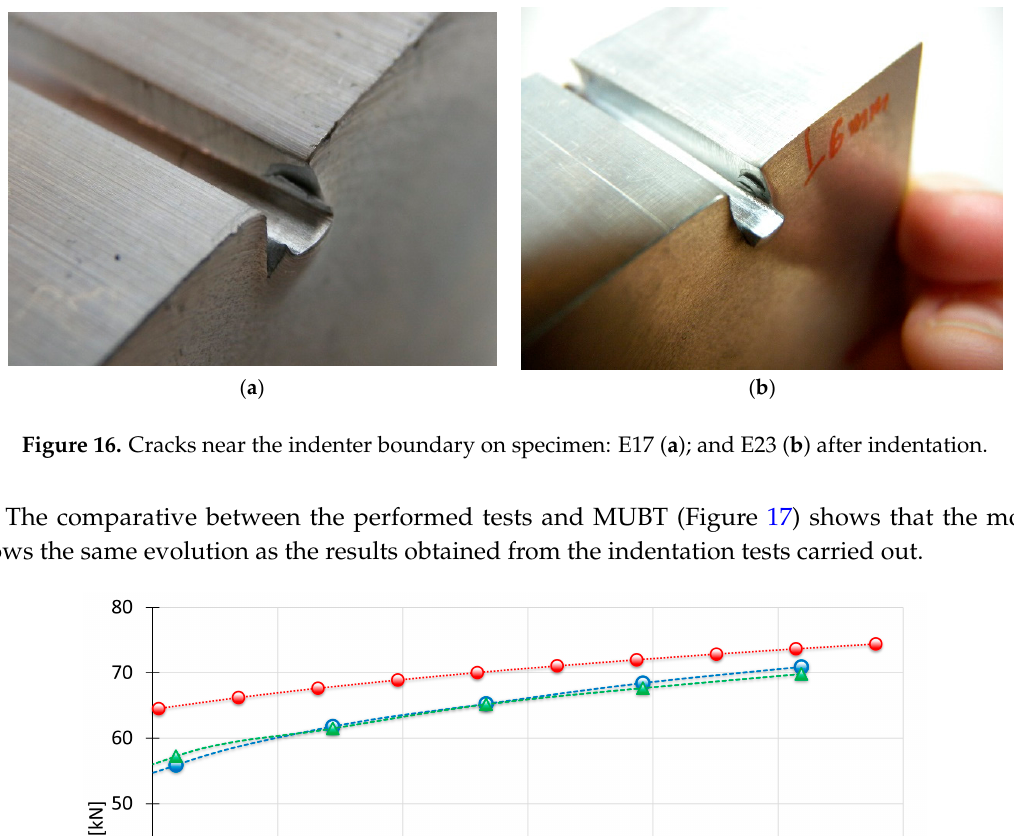
Figure 15. Indentation forces obtained from test with different speeds.